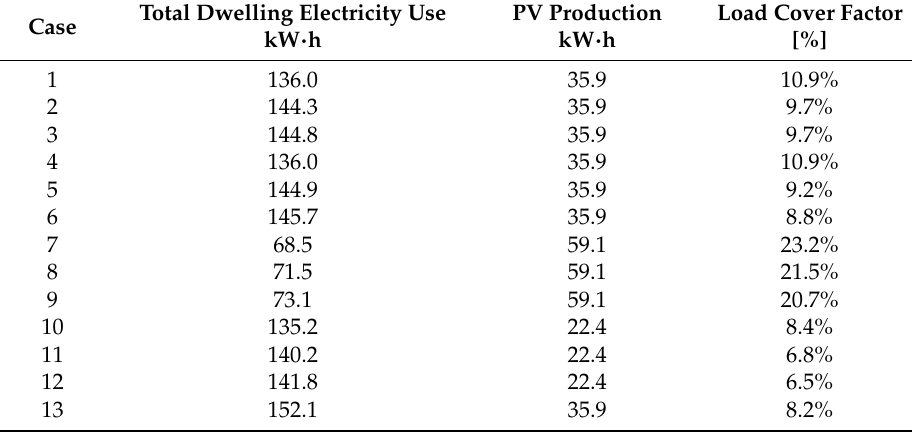
Table 6. Results of the load cover factor. The total electricity use includes the heat pump, the appliances, and lighting. The load cover factor is calculated according to [27] (hence it should be noted that it is not a direct ratio between the production and consumption of the